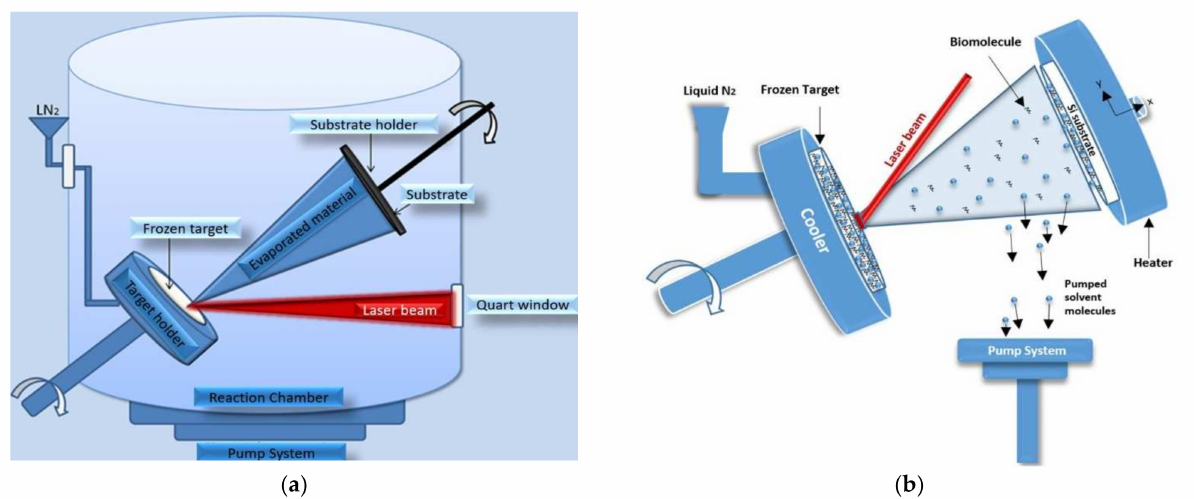
Figure 6. Schematic representation of ( a ) MAPLE system and ( b ) fundamental physico-chemical processes in MAPLE (reproduced from